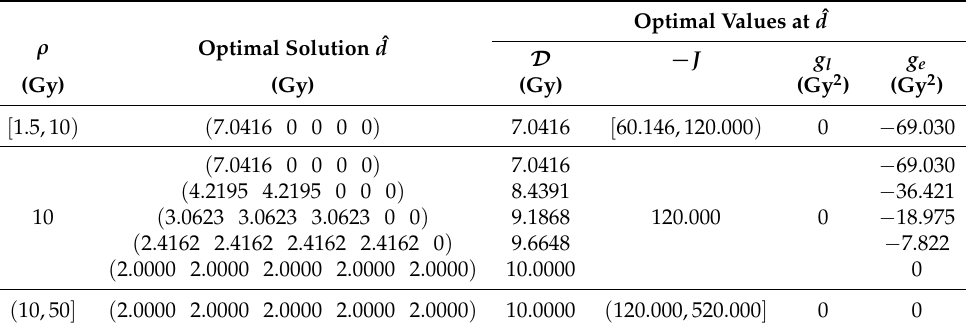
Table 6. Numerical solutions to Problem 1 in the absence of incomplete repair. Actual dose to normal tissue reduced by a factor f = 0.3, resulting in h l = 120.0 Gy 2 and h e = 353.3 Gy 2 . Optimal solutions for ρ ∈ [ 1.5,50 ] Gy. ˆ d , optimal solution; D , optimal total